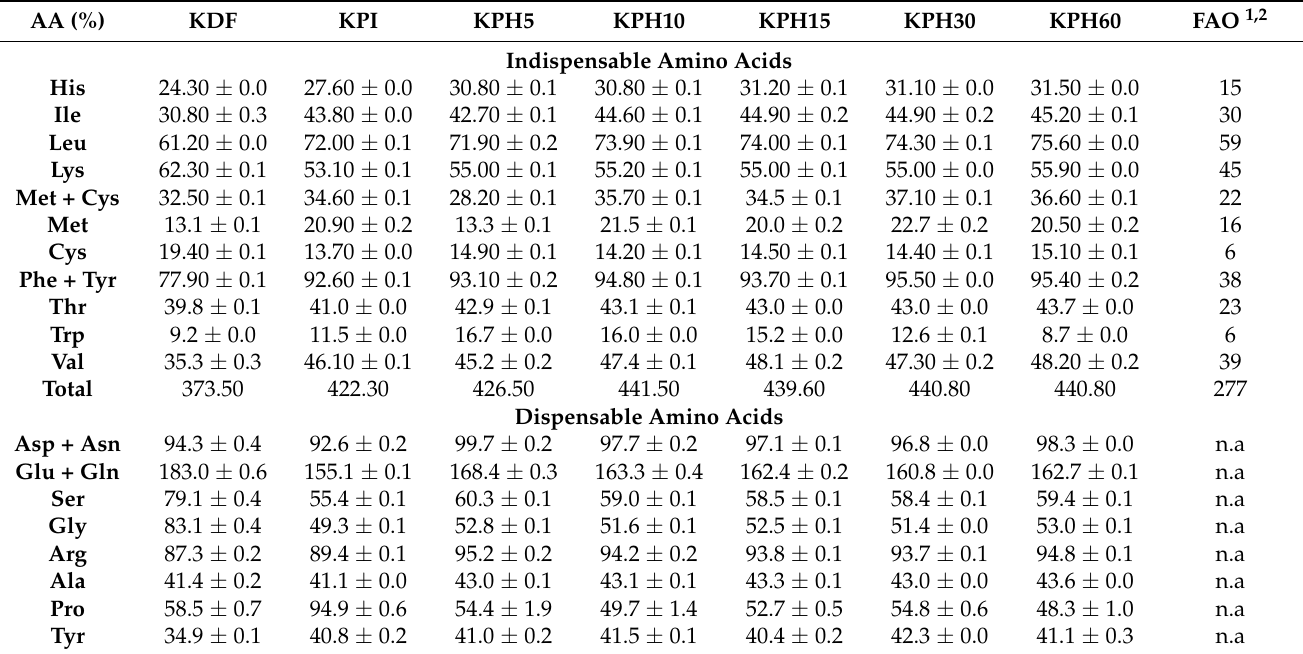
Table 2. Amino acid composition of kiwicha protein products and adult